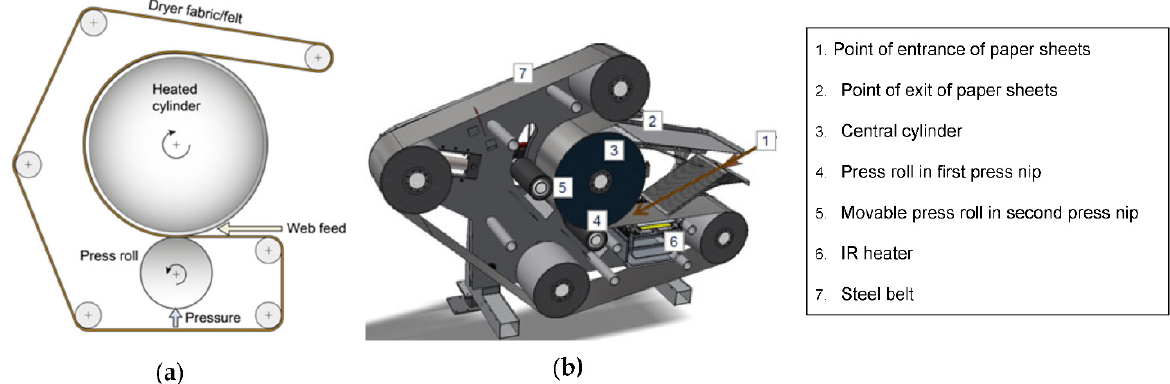
Figure 1. ( a ) Felted, oil-heated cylinder press [16] operated at MoRe Research Örnsköldsvik AB, Örnsköldsvik, Sweden. Illustration: Mats Rundlöf, Capisco, Norrköping, Sweden. ( b ) Infrared-heated press based on a steel belt [17] produced by Ipco AB, Sandviken, Sweden. Both pictures are reproduced under the terms of the CC BY license.